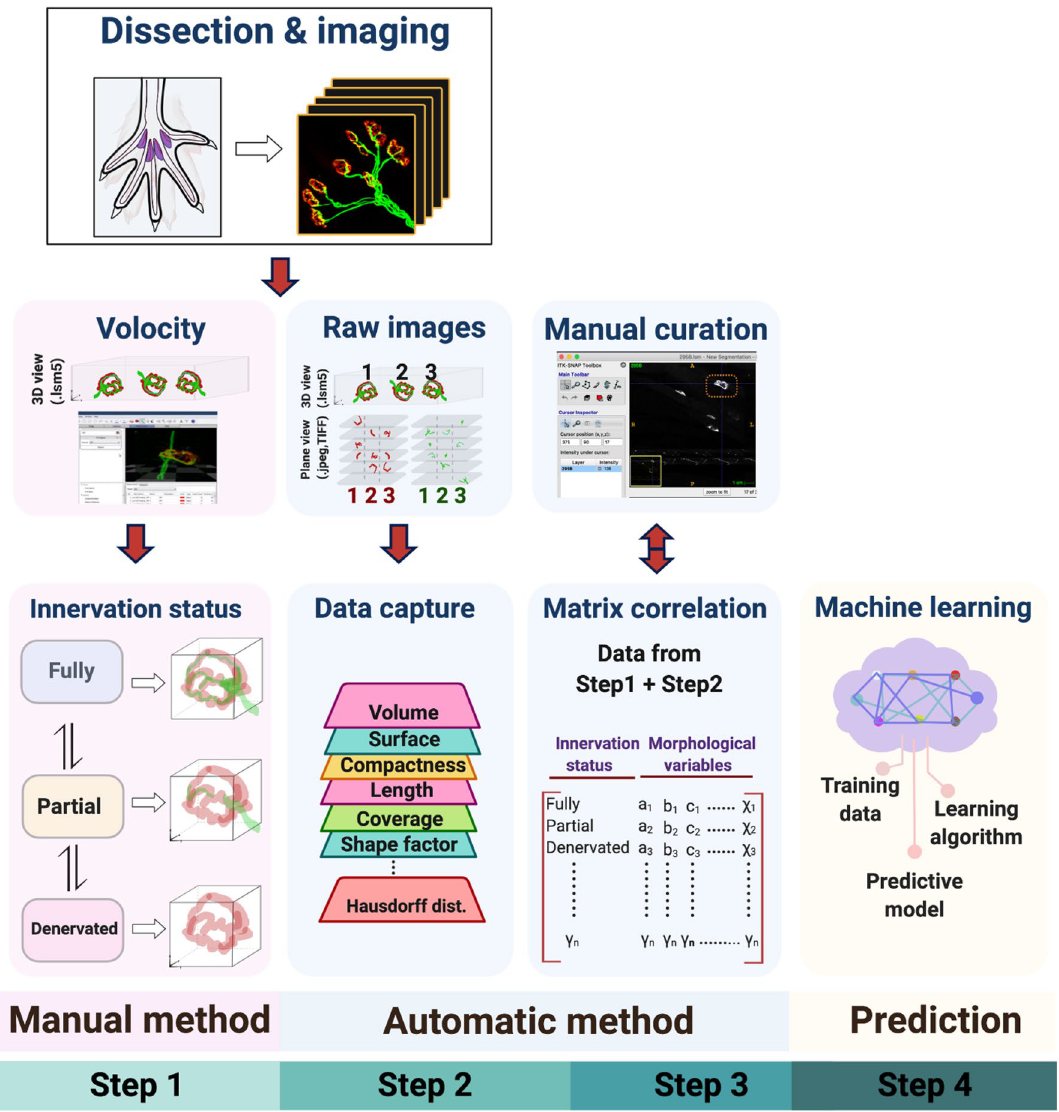
Figure 1. NMJ-Analyser workflow. NMJ-Analyser consists of four sequential steps. (Step 1) Muscles are dissected, immunostained and digitalised (here, hindlimb lumbrical muscles). NMJ innervation status is manually assessed (full, partial, denervated) using an imaging package. (Step 2) Morphological analysis of NMJs requires raw images (plane view) to be formatted (.TIFF/.JPEG/.PNG). Features are captured for individual pre- or post-synaptic NMJs and for parameters involving interactions between these two components. (Step 3) Data from NMJ innervation status and morphological features are integrated into a matrix. Additional manual curation can be performed to confirm the whole individual NMJ was captured and its entire 3D structure analysed using NMJ-Analyser. (Step 4) Curated data output are divided into training and predictive sets. The training set is input into a machine learning model while the predictive set is used to predict the NMJ innervation status. Additional File 2 contains a detailed tutorial of how to use